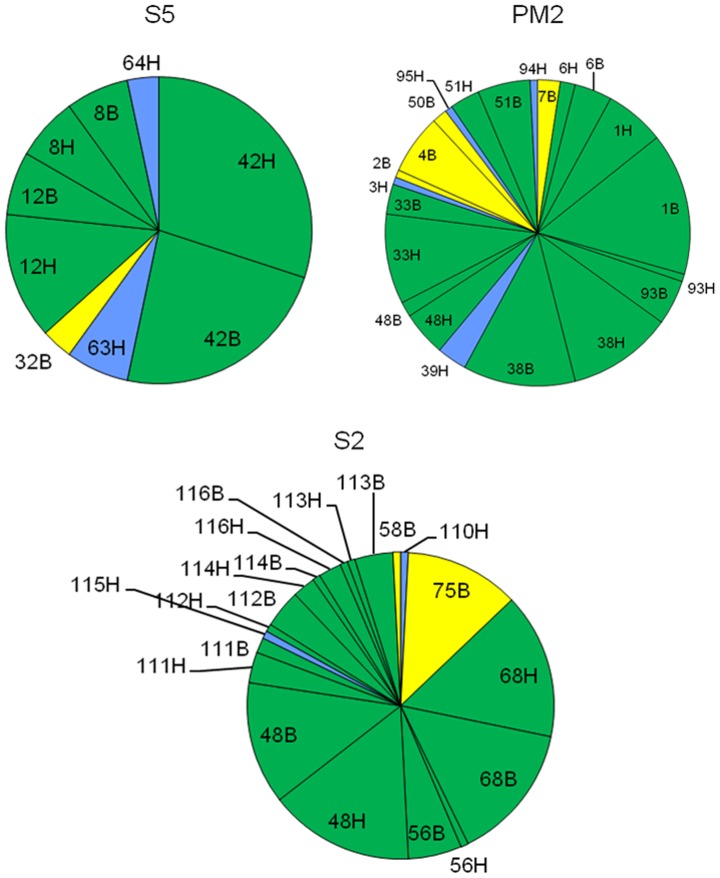
Proportion of each allele among the head and body lice.The names (ID numbers) of the alleles are mentioned followed by the letter H for head lice and B for body lice. The alleles found in both the head and body lice are shown in green. The blue alleles were found only in the head lice, and the yellow alleles were found only in the body lice.